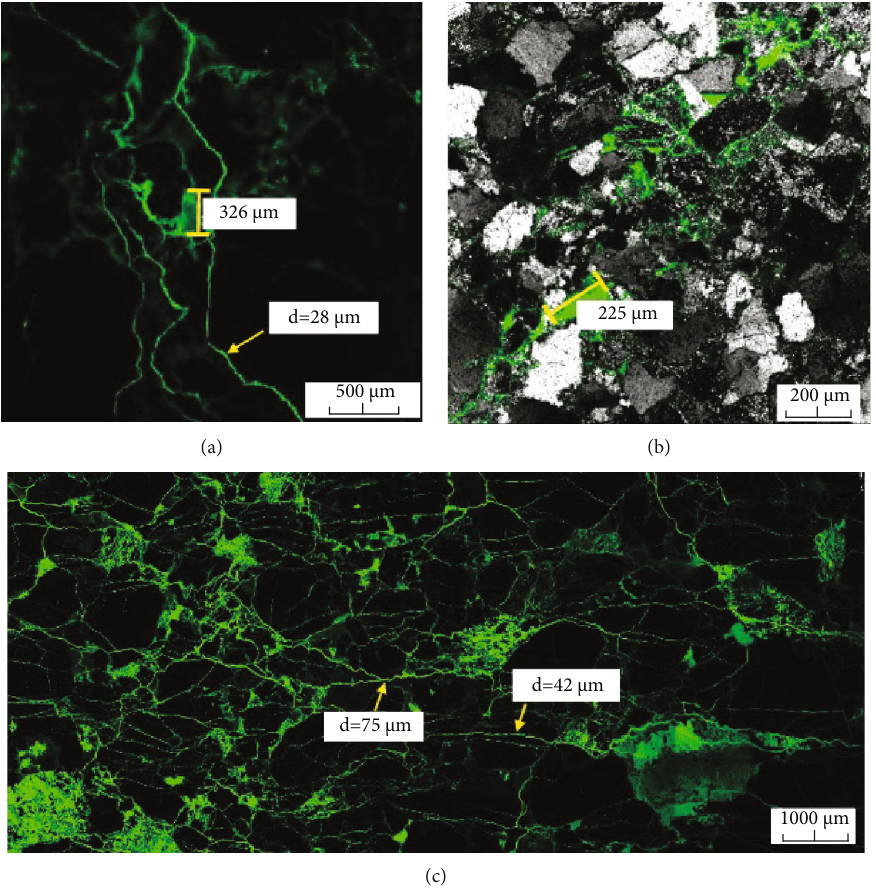
Figure 5: Scanning laser confocal microscope photomicrographs showing slot pore characteristics in the Ahe Formation of Dibei area. (a) a: corroded bands with clustering tiny corrosion pores. Tiny pores are clear. (c) Well Well Yn2: clear structural fractures. (b) Well Yn2, J 1 Table 2: Result of rate-controlled mercury penetration in the study